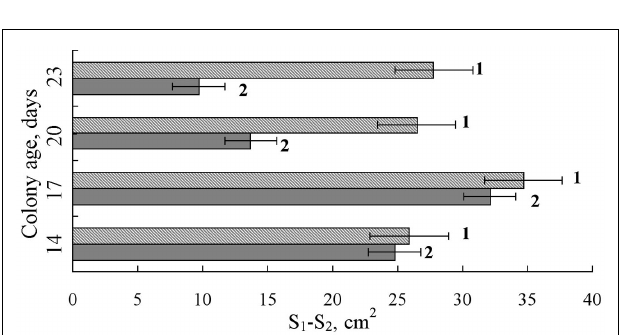
FIGURE 9 | Progressive increase in differences (S 1 –S 2 ) between colony areas (cm 2 ) of Stagonospora nodorum treated (S 2 ) with Dividend combined with FCL (1) or Dividend alone (2), compared with area of control colonies (S 1 ), after 14, 17, 20, and 23days of culture. FCL – filtrate of cultural liquid produced by a biocontrol isolate of F. sambucinum , FS-94 at a final concentration of 2 volume percent. Dividend concentration is 0.01ppm. Bars represent 2 × SE.